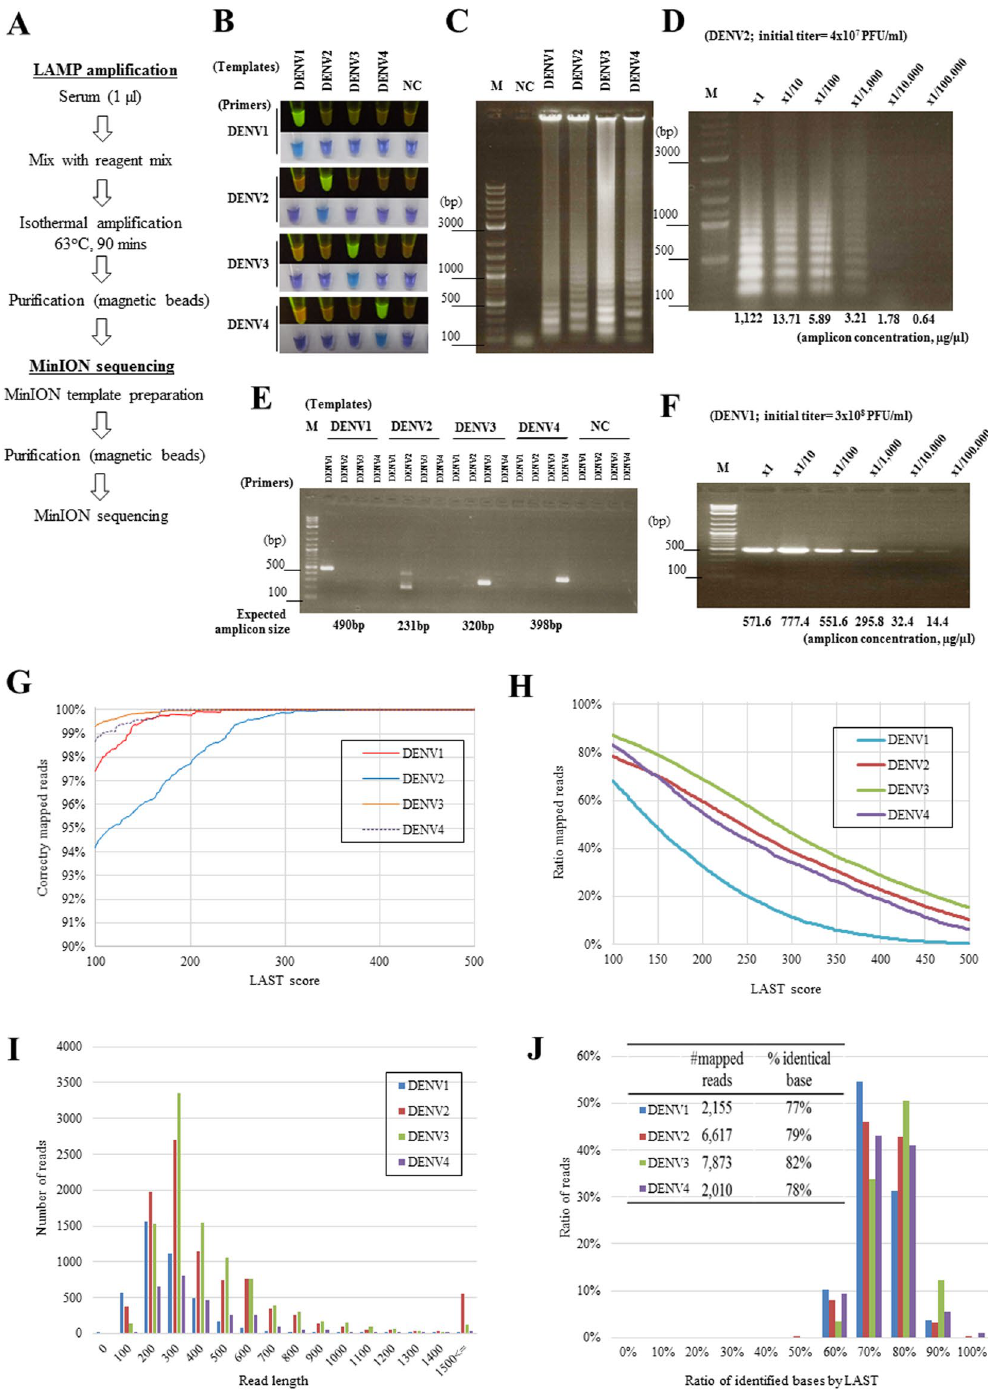
Figure 1. Serotyping analysis of dengue virus using LAMP and MinION. ( A ) Schematic representation of the method using the LAMP amplification and MinION sequencing. ( B ) UV and visual light images and ( C ) agarose gel electrophoresis image of the LAMP amplicons obtained from the control templates. For ( B ) the top rows for each serotype are the UV images, and the bottom rows are under visual light. ( D ) Electrophoresis image of the LAMP products generated from a serially diluted control template of DENV2. The amplicon concentration was calculated using the Agilent Bioanalyzer. ( E ) RT-PCR amplification of the control viruses. ( F ) RT-PCR analysis of the DENV1 serially diluted control template. The amplicon concentration was calculated by the Agilent Bioanalyzer. ( G ) Precision and ( H ) recall rates of the sequence reads recovered at the cut-off score of LAST indicated on the x -axis. ( I ) Length distribution of the aligned reads. ( J ) The accuracy of the sequencing obtained by the flow cell version 7 was calculated by considering the matched bases between each sequence and the corresponding reference genome. The images from ( B ) to ( F ) are representative of three biological